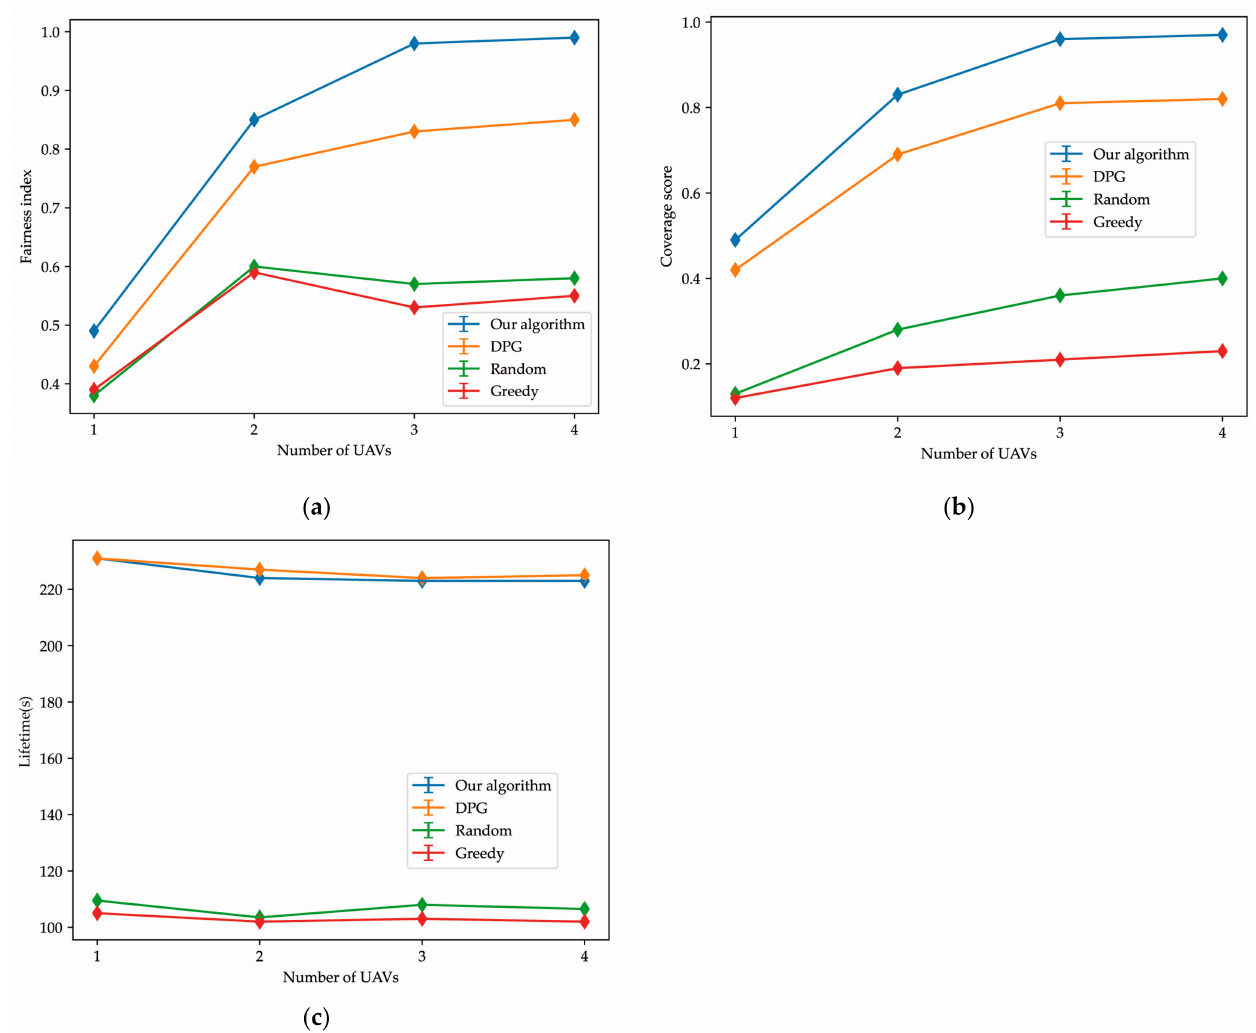
Figure 7. ( a ) Fairness index trend changing with the number of UAVs changes; ( b ) coverage score trend changing with the number of UAVs changes; ( c ) lifetime trend changing with the number of UAVs